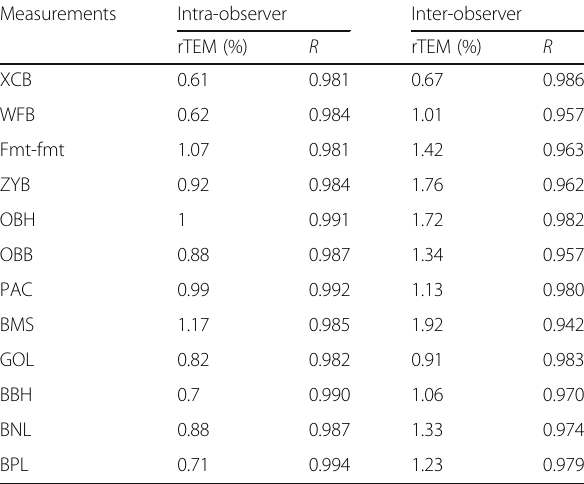
Table 3 Intra-observer and inter-observer of relative technical error of measurements (rTEM %) and coefficient of reliability ( R ) for all skull measurements ( n = 10